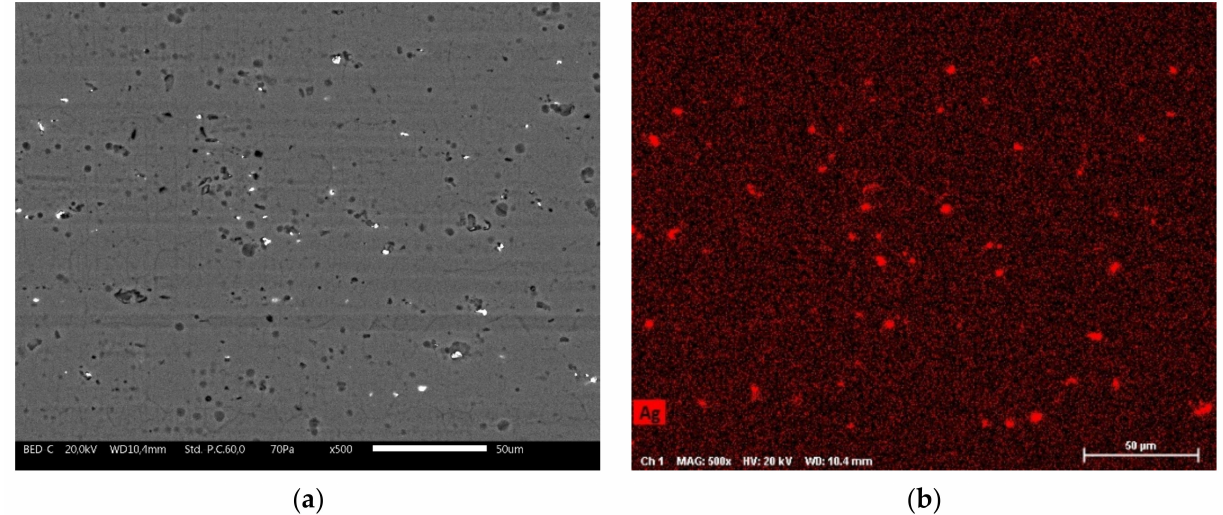
Figure 9. SEM micrograph of sample A surface morphology, taken after 10,000 cycles of scrub test ( a ), and relative EDXS map of Ag element ( b